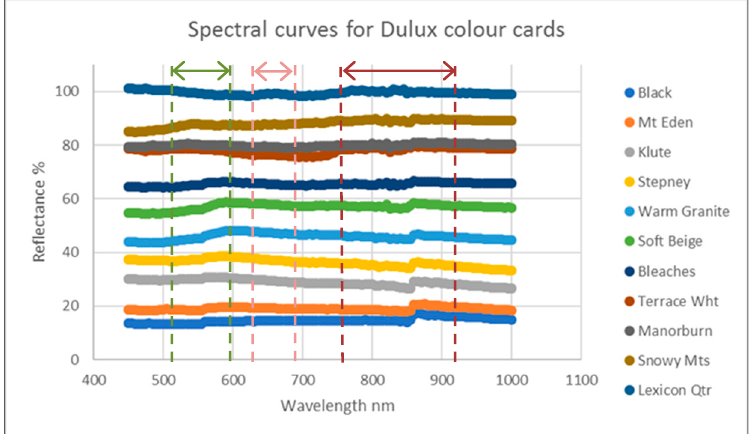
Figure 1. Dulux colour cards reflectance curves 450–1000 nm at 5 nm intervals.